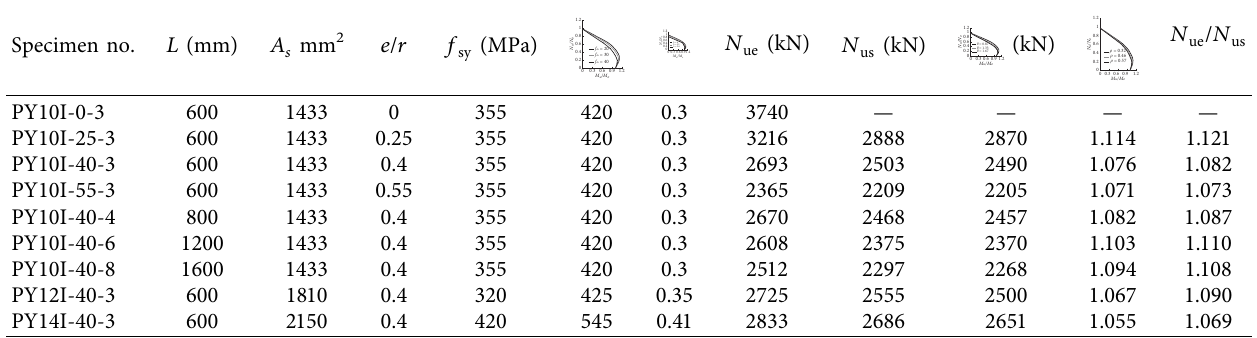
Table 1: Tested parameters and results.